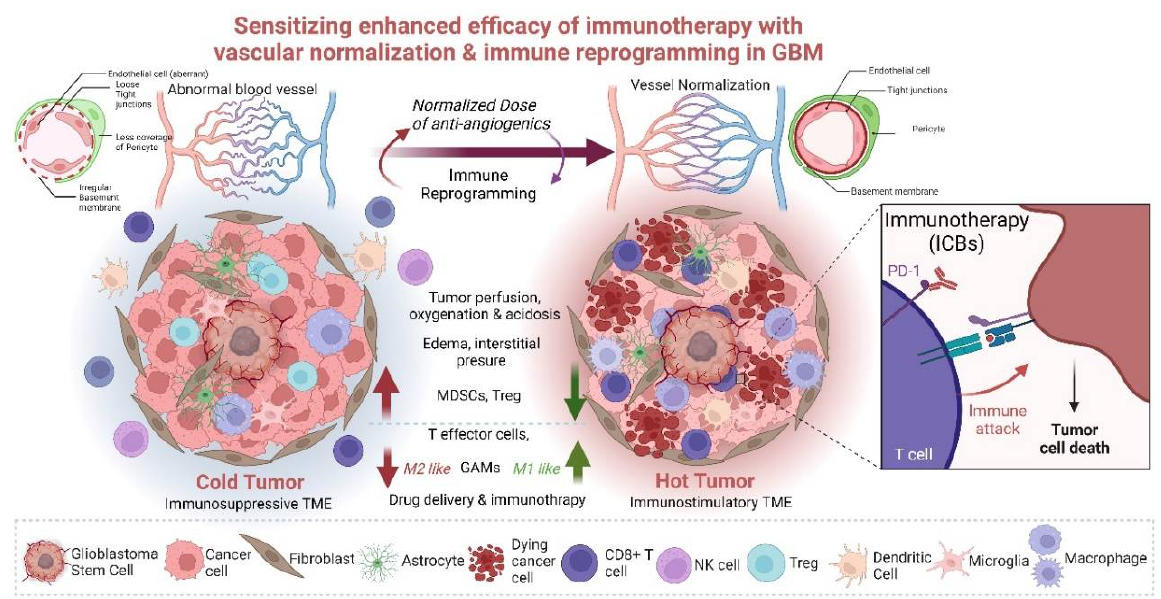
Figure 2. Enhancing immunotherapy in Glioblastoma (GBM) with the reciprocal regulation of the vascular normalization and immune reprogramming. The “cold”, immunosuppressive tumor microenvironment (TME) in GBM is depicted with no effector T cells, dendritic cells (DCs) and natural killer (NK) cells but with immunosuppressive myeloid derived suppressor cells (MDSCs), M2-like glioma associated macrophages (GAMs) and T regulatory cells (Tregs). The “cold” tumor TME is characterized with abnormal tumor blood vessels that are tortuous and leaky due to irregular basement membrane, aberrant endothelial cells (ECs) with loose tight junctions, and immature and irregular pericyte coverage. These events lead to less perfusion and oxygenation (hypoxia) which increases an acidic microenvironment, consequently leading to increased edema, interstitial pressure, less drug delivery and unsuccessful immunotherapy. Using a judicious (normalized) dose of anti-angiogenics, vessel normalization can be attained where the basement membrane is regular, with proper ECs, tight junctions and matured pericyte coverage that fortify the vessels leading to increased vessel perfusion, oxygenation and reducing acidosis. Less edema and interstitial pressure create a conducive TME for homing effector T cells and creating “hot” immunostimulatory TME that homes DCs, NK cells and no or less Tregs and MDSCs. M1-like macrophages are present along with microglia, and other stromal cells. This reciprocal regulation of vascular normalization leading to immune reprogramming and vice versa sensitizes the “hot” tumor for effective immunotherapy. The purple large arrow shows that by reciprocal regulation of immune reprogramming and normal- ized dose of anti-angiogenics can induce vessel normalization from abnormal vessel architecture. The red arrows depict immune characteristics of “cold tumor with increased MDSCs and Tregs and less T effector cells and more M2 like GAMs leading to increased edema, interstitial pressure, aci- dosis, and less tumor perfusion, oxygenation, drug delivery and less affective immunotherapy. The green arrows depict immune characteristics of “hot” tumor with less MDSCs and Tregs and more T effector cells and more M1 like GAMs leading to decreased edema, interstitial pressure, acidosis, and more tumor perfusion, oxygenation, drug delivery and more affective immunotherapy. Created with BioRender.com. Author Contributions: Conceptualization, M.G.; Writing—original draft preparation, M.G. and A.M.L.; writing—review and editing, B.K., M.G., and A.M.L. All authors have read and agreed to the published version of the manuscript. Funding: M.G. is supported by PACIFIC Call 1 (Polish Academy of Science) Agreement No. PAN.BFB.S.BDN.619.022.2021 and this project received funding from the European Union’s Hori- zon 2020 research and innovation programme under the Marie Skłodowska-Curie grant agreement No 847639 and from the Ministry of Education and Science. A.M.L. is supported by funding from the National Science Centre, Poland grant 2020/39/B/NZ4/02683. Conflicts of Interest: The authors declare no conflict of interest